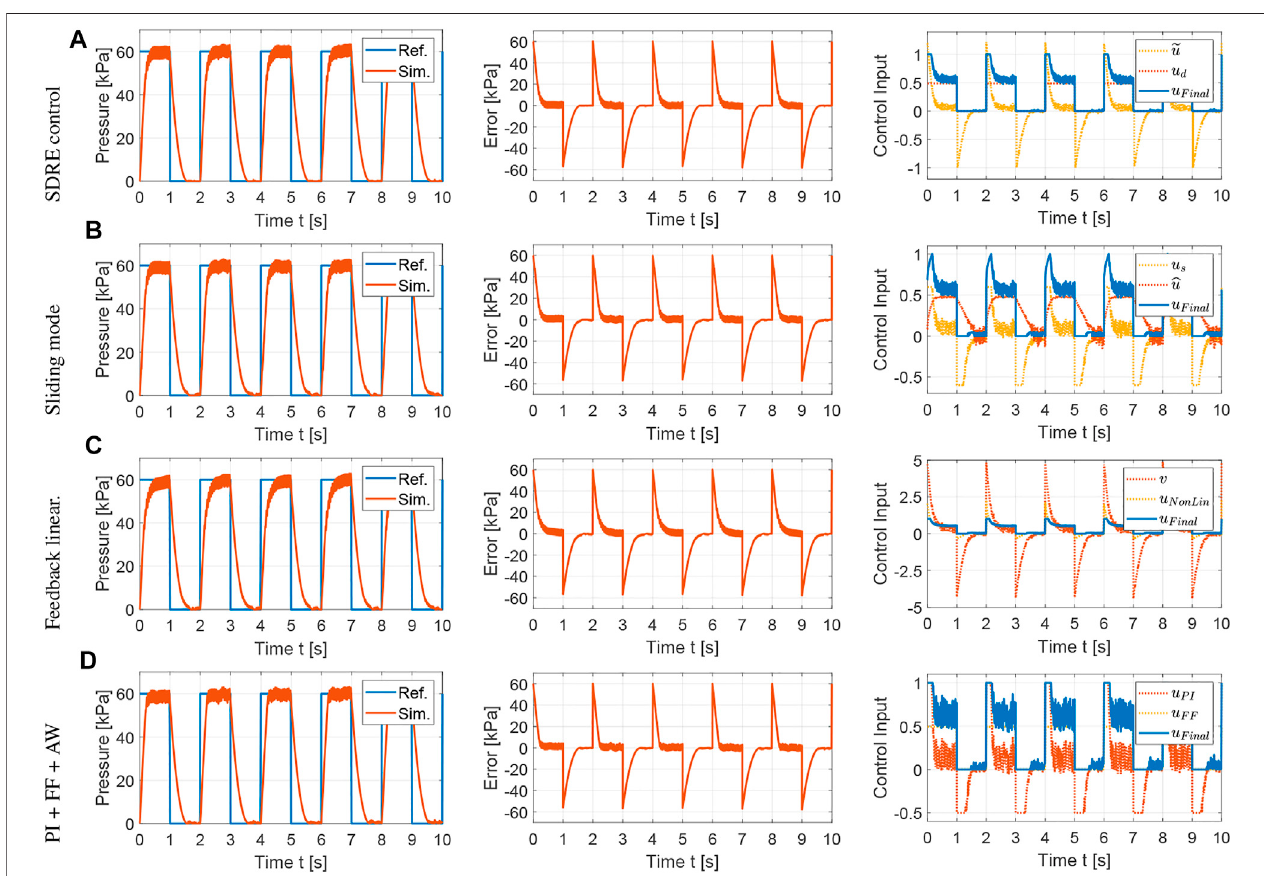
FIGURE3| SimulationresultsforthecomparisonofnonlinearcontrolstrategiesusingtheSimscapeFluidsmodel:trackingperformance,trackingerrorandcontrol input for square wave with T = 2 s. (A) SDRE control: Q (cid:1) 5 and R (cid:1) 10, ~ u is the feedback term, u d is the feedforward term, and u Final is the control applied to the valve after saturation. (B) Integral augmented sliding mode control: k s (cid:1) 0 . 6, k i (cid:1) 0 . 01 and Φ (cid:1) 0 . 2, u s is the discontinuous term, ^ u is the equivalent control, and u Final is the controlapplied tothevalveaftersaturation. (C) Feedbacklinearizationwithintegralaction: k (cid:1) 8and k i (cid:1) 0 . 01, v isthelinearcontrolterm, u NonLin isthetotalcontrol, and u Final is the control applied to the valve after saturation. (D) PI controller with feedforward and anti-windup: k p (cid:1) 5 and k i (cid:1) 0 . 5, u PI is the PI control term, u FF is the feedforward term, and u Final is the control applied to the valve after saturation.